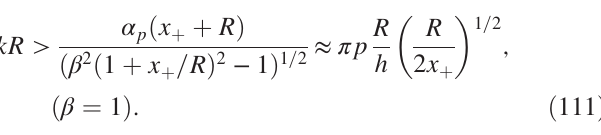
FIG. 13. The sum to p ¼ 9 of the straight after the bend ( s ¼ 5 . 55 m) for kR ¼ 5 × 10 5 .